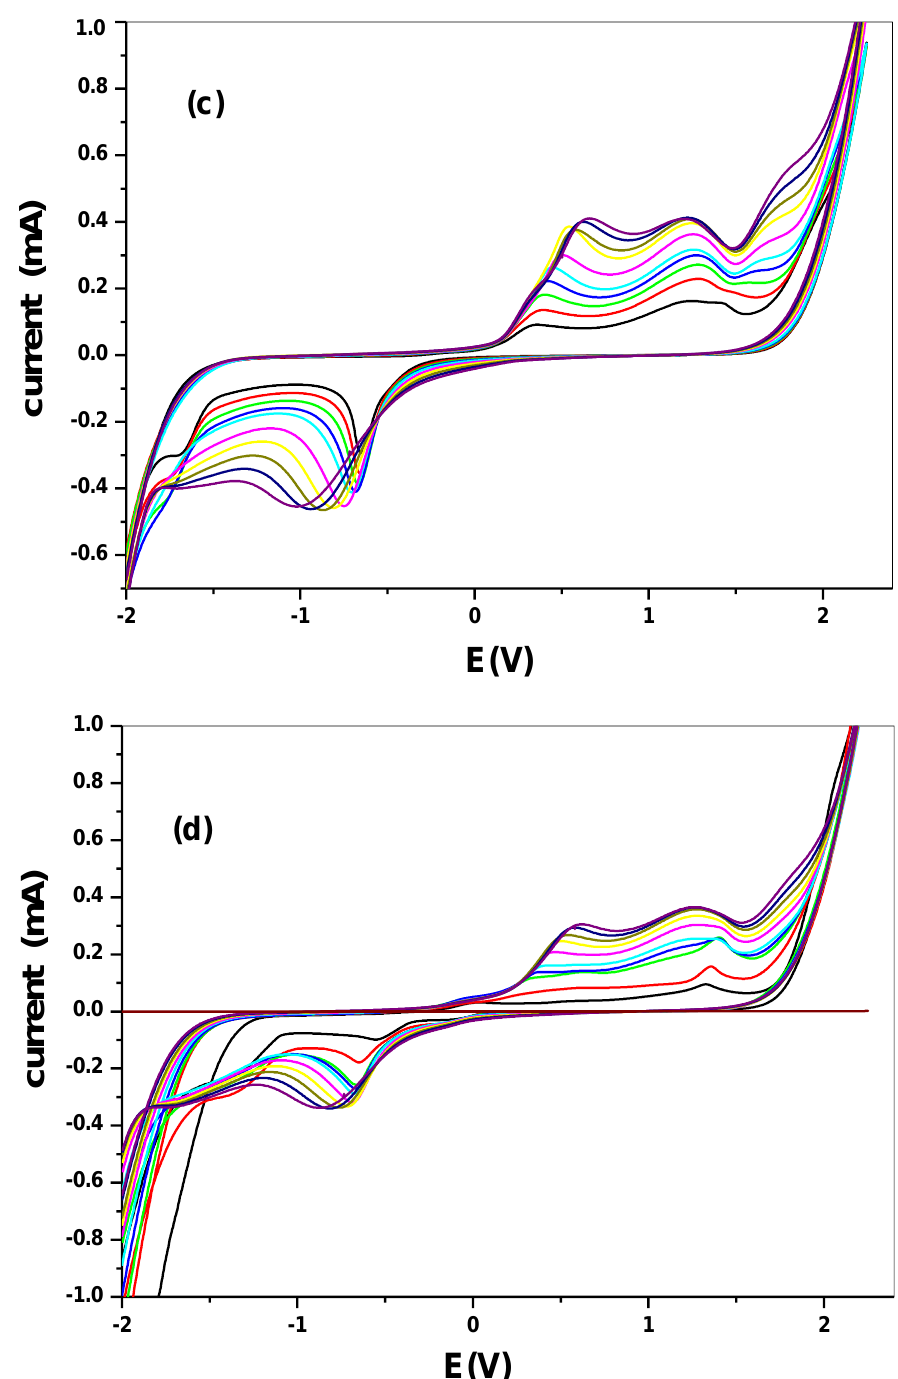
Figure 8. Scan rate voltammogram of ( a ) SPC/cCuO, ( b ) SPC/wCuO, ( c ) SPC/aCuO, and ( d ) SPC/eCuO nanoparticles in 10 mM [Fe(CN) 6 ] 4 − / [Fe(CN) 6 ] 3 − solution prepared in 0.1 M PBS at varying scan rates (50–400 mV/s).